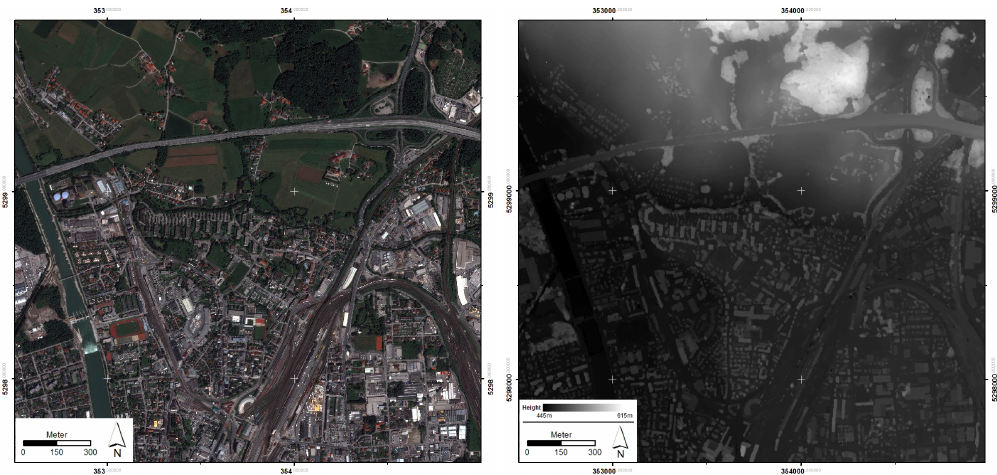
Figure 1. Left : Pléiades-1B satellite image, acquired on 28 May 2013, true color pansharpened to 0.7 m resolution; Right : stereo-imagery digital surface model (DSM) data, displayed in